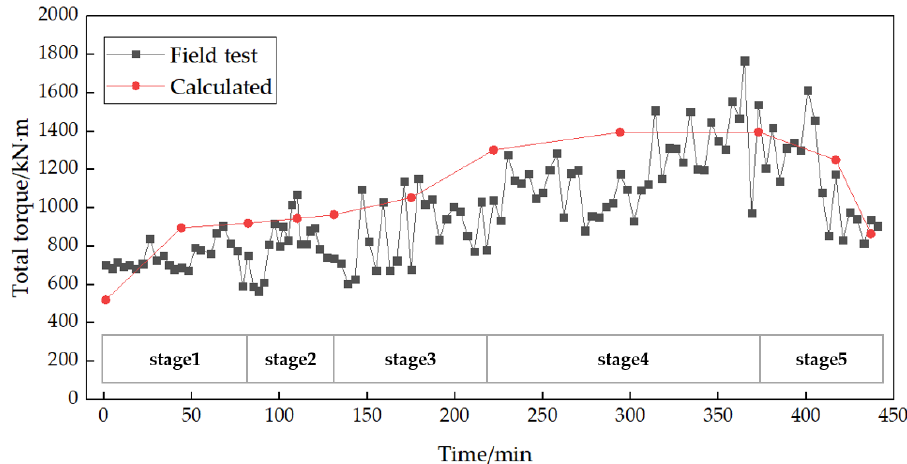
Figure 11. Total torque at each cutting stage.